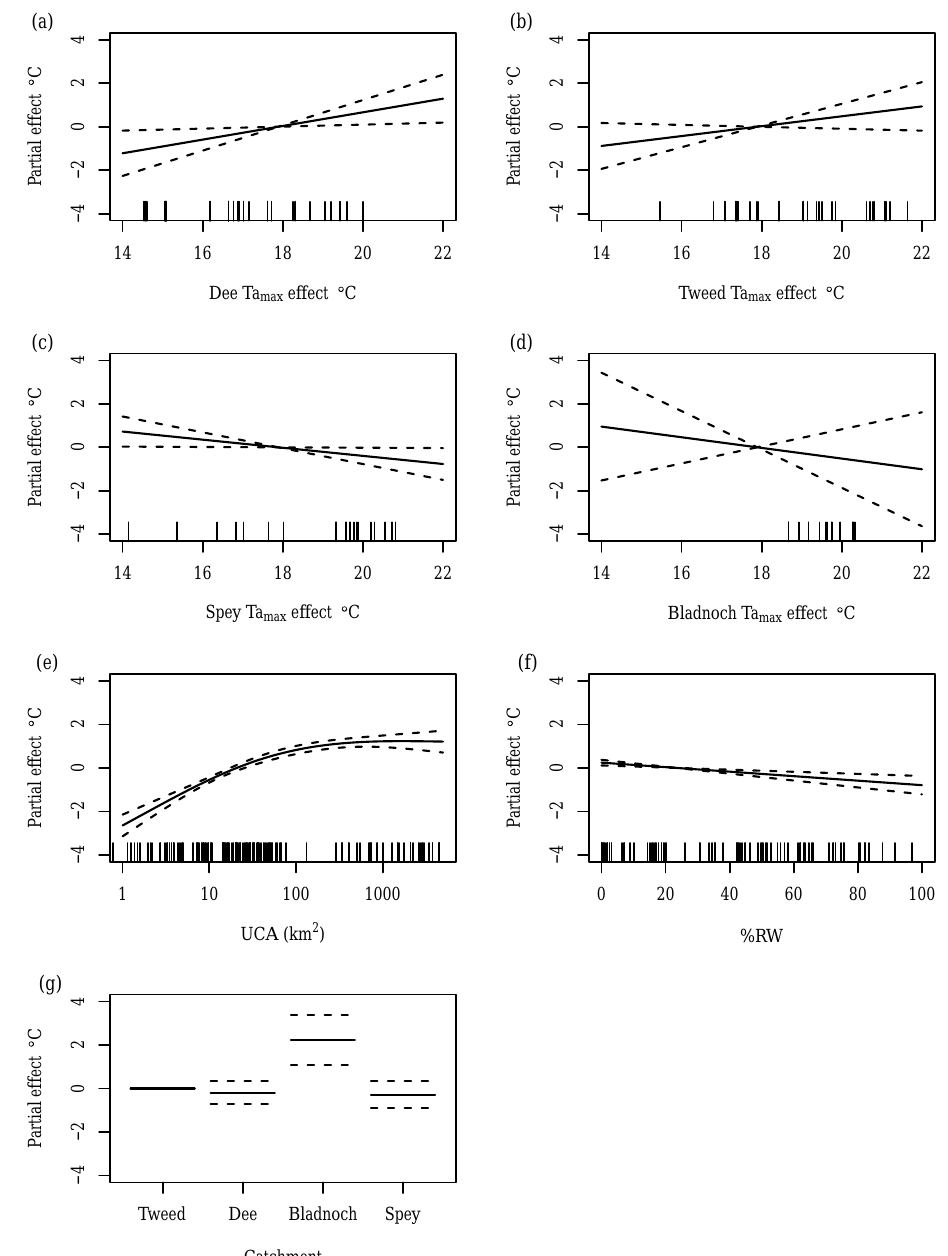
Figure 8. Multi-catchment LS_ T a model effects with pointwise 95% confidence bands: (a) Dee T a (d) Bladnoch T a , (e) UCA, (f) %RW and (g) max